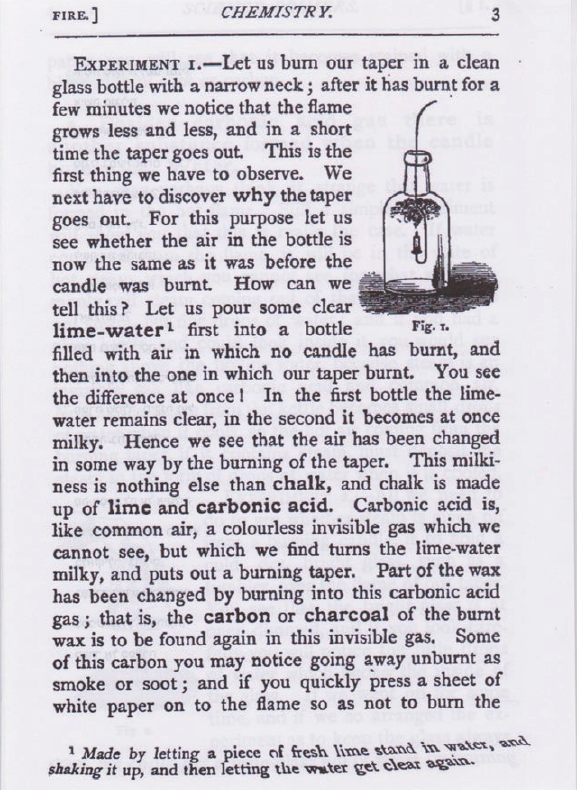
Figure 1. Candle burning experiment.